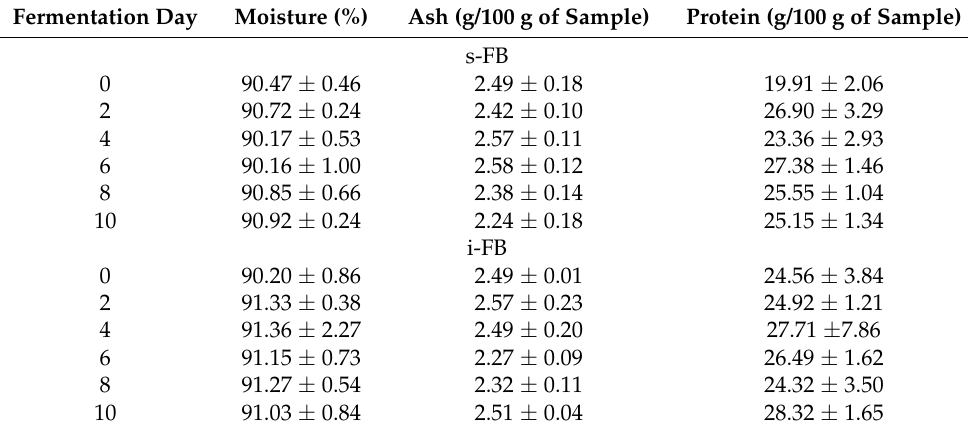
Table 1. Chemical composition of freeze-dried fermented broccoli.